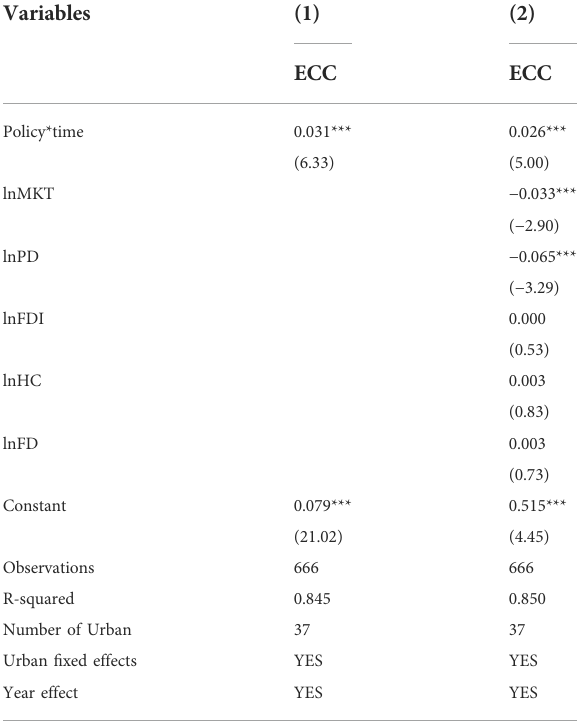
TABLE 4 PSM-DID inspection